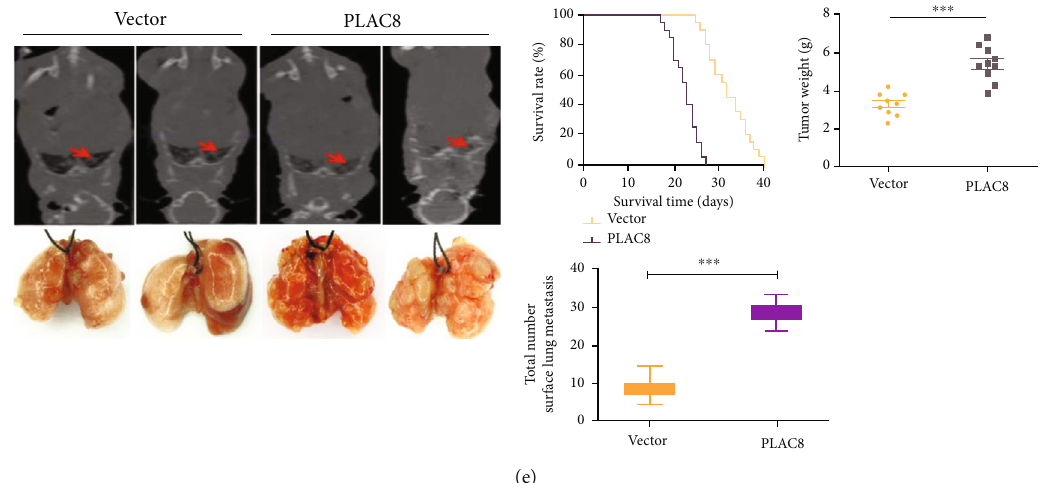
Figure 2: Overexpression of PLAC8 promotes the proliferation and migration of lung cancer in vitro and in vivo. (a) Protein level con fi rms overexpression of PLAC8. (b) E ff ect of PLAC8 overexpression on lung cancer cell proliferation. (c) E ff ect of PLAC8 overexpression on lung cancer cell clone proliferation (left: plate clone; right: soft agar clone). (d) E ff ect of PLAC8 overexpression on lung cancer cell migration. (e) E ff ect of PLAC8 overexpression on survival time ( ∗ p < 0 : 05 ), tumor size ( ∗∗ p < 0 : 01 ), and tumor metastasis ( ∗∗∗ p < 0 : 001 ) of lung cancer mice. All these cell biological function assays were